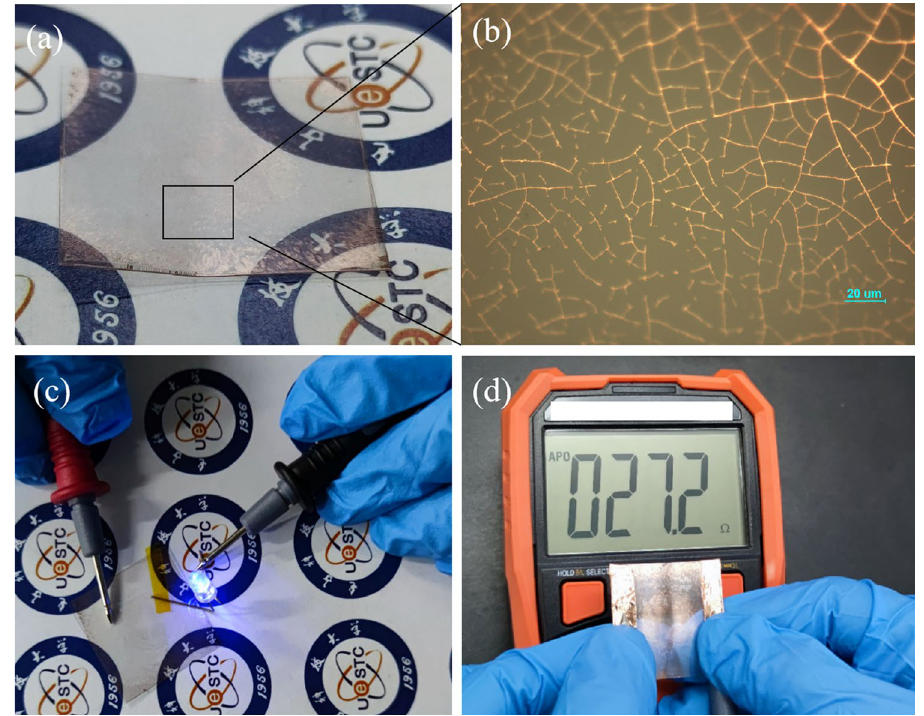
Figure 9. Characterization of TCFs after bending test, ( a ) TCFs after bending, ( b ) optical microscope at the crease, ( c ) schematic diagram of conductivity of TCFs, ( d ) resistance of TCFs after bending.